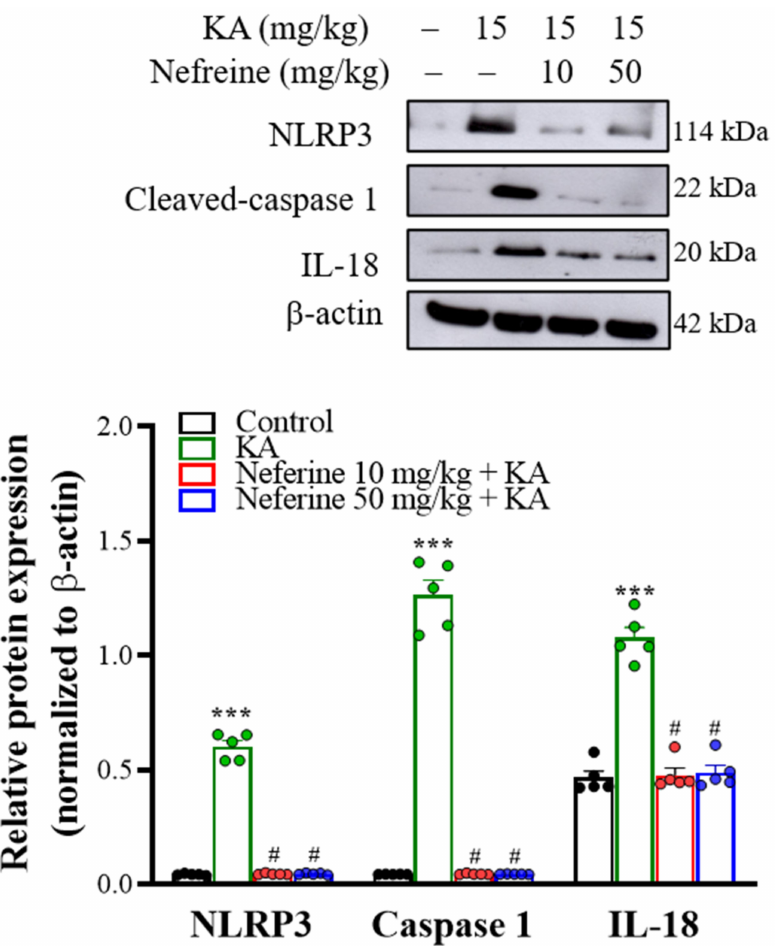
Figure 7. Western blot analyses of NLRP3 inflammasome-related proteins in rat hippocampal tissue. Representative images in the different groups and densitometric values for NLRP3, active caspase-1, and IL-18 were normalized to β -actin levels ( n = 5 rats/group). Statistical results of the immunoblot analysis show that neferine reduced the band intensity of NLRP3, active caspase-1, and IL-18 (one-way ANOVA). *** p < 0.05 vs. control group. # p < 0.05 vs. KA-treated